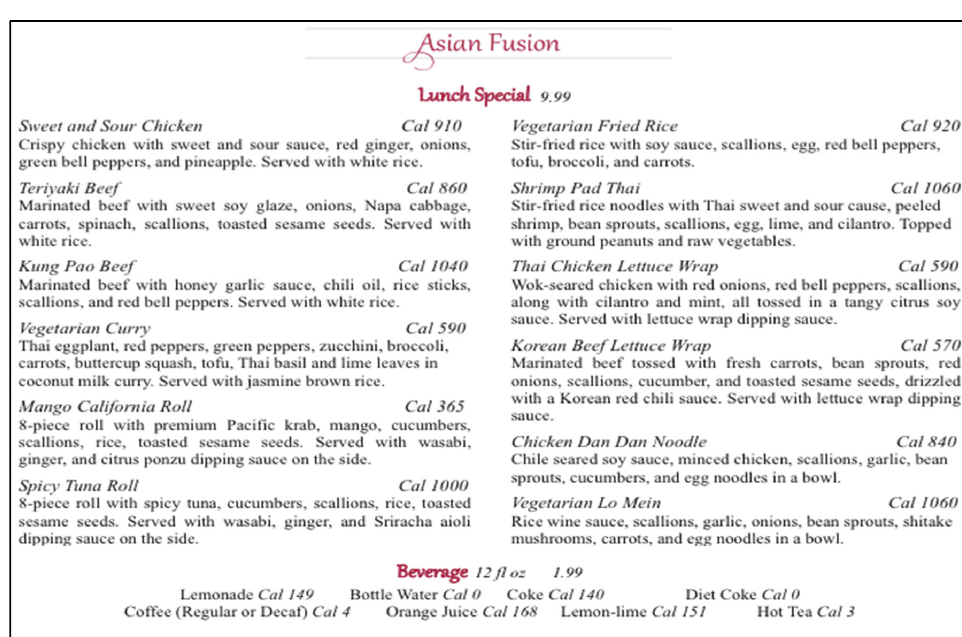
Figure A1. Asian Fusion Control Menu.